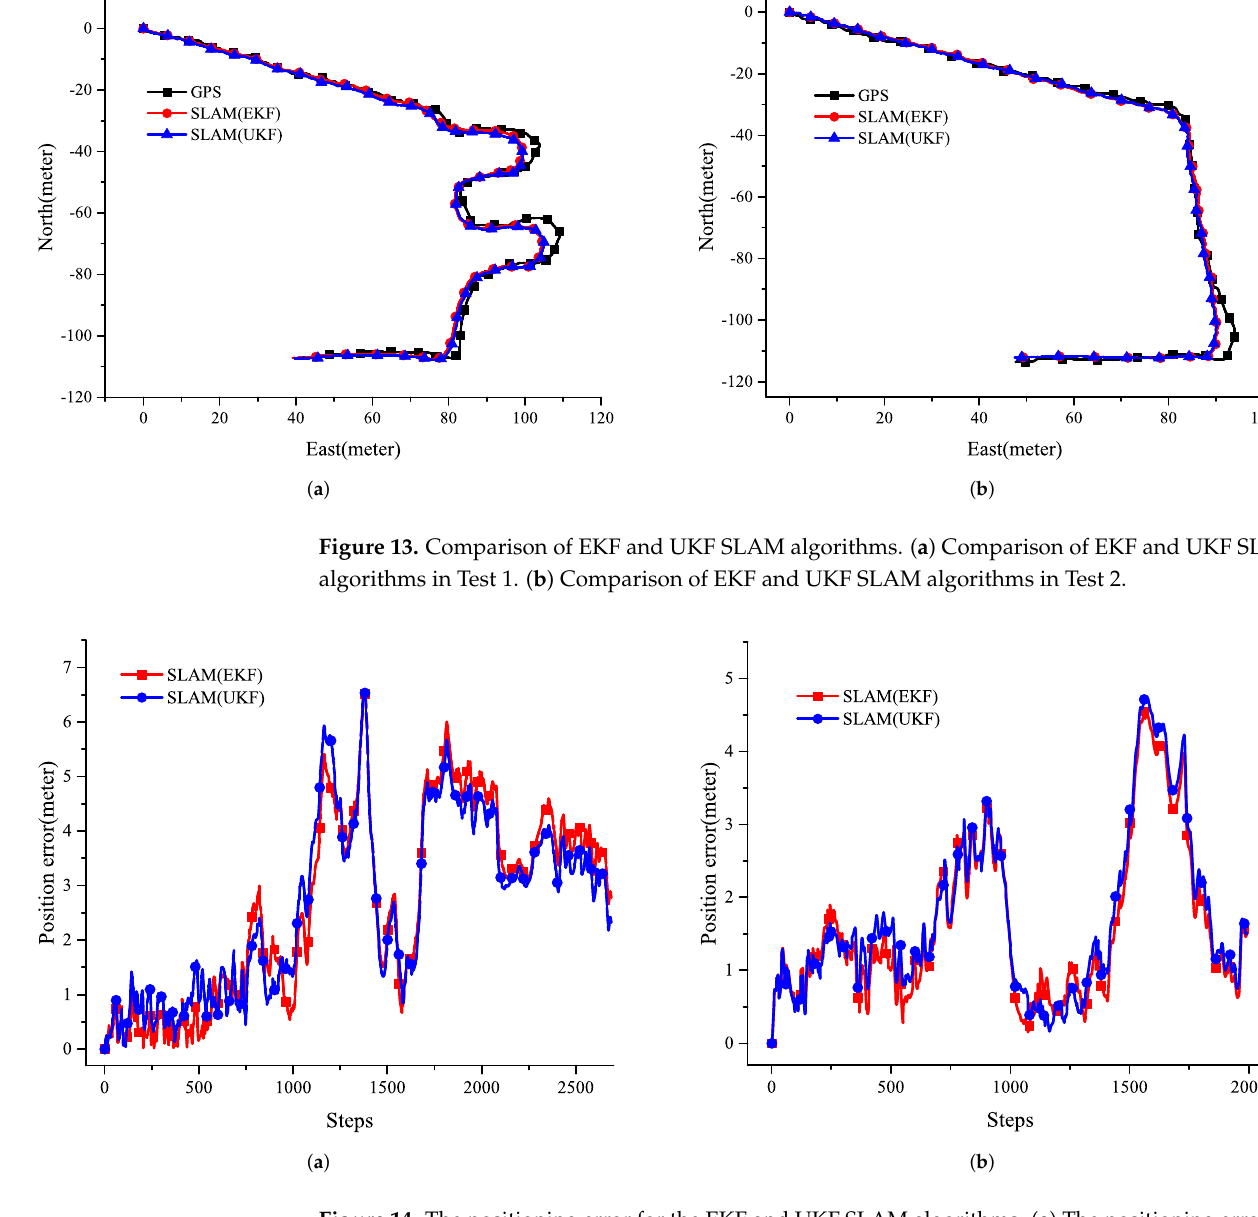
Figure 14. The positioning error for the EKF and UKF SLAM algorithms. ( a ) The positioning error for the EKF and UKF SLAM algorithms in Test 1. ( b ) The positioning error for the EKF and UKF SLAM algorithms in Test 2. Table 2. RMSE of positioning under the EKF and UKF filters; unit: